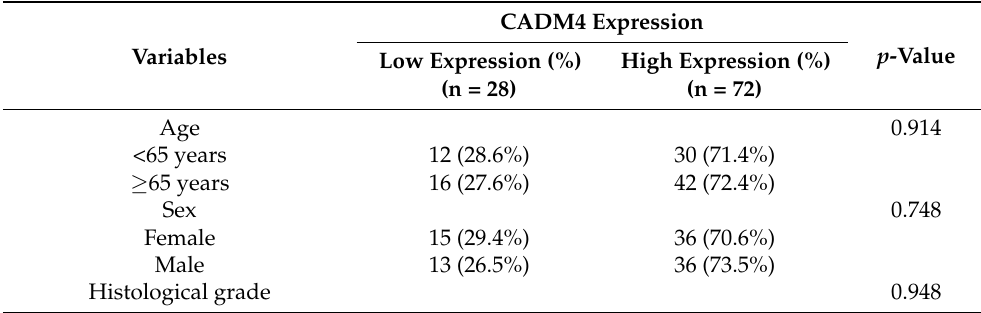
Table 2. Correlations between CADM4 expression and clinicopathological characteristics in patients with gallbladder cancer (n =